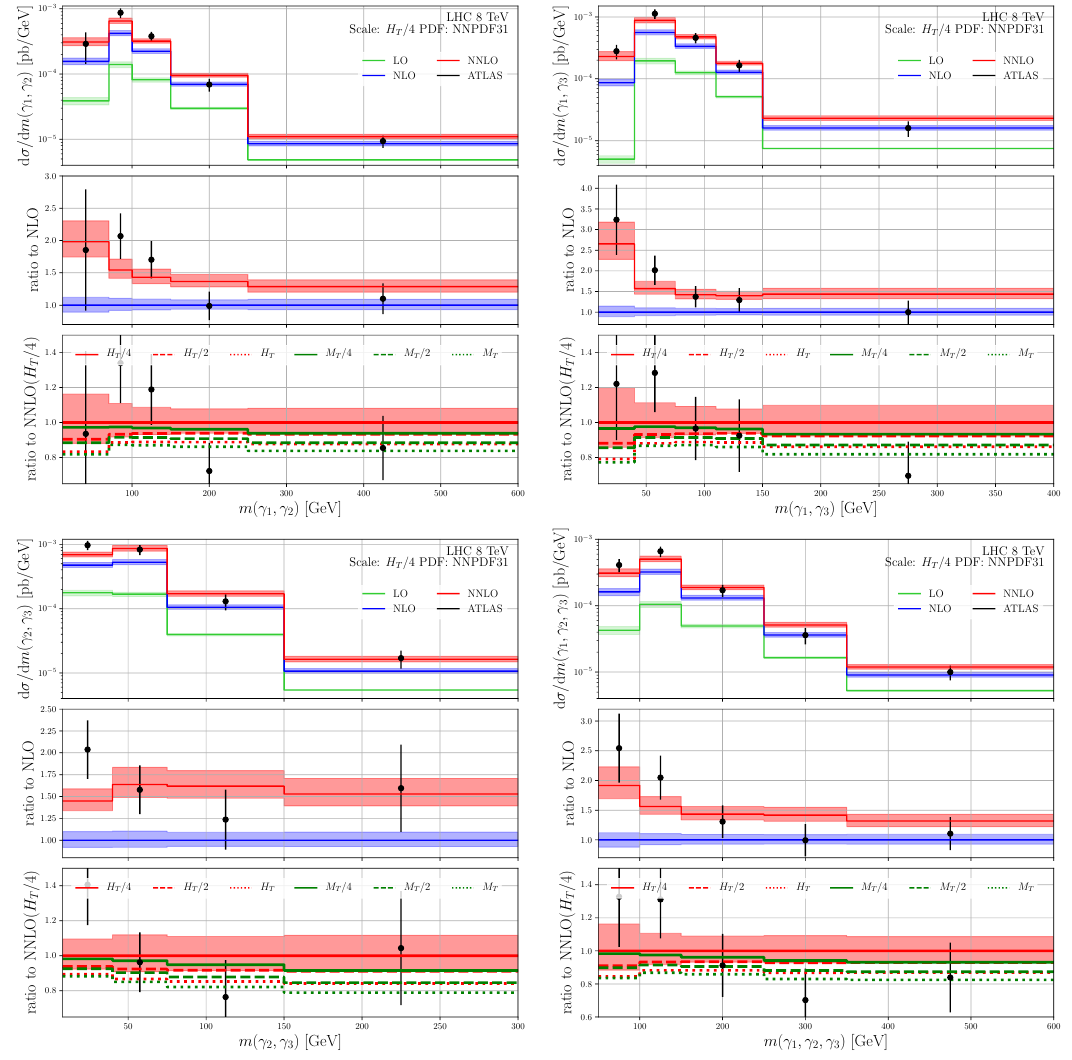
Figure 5 . As in (cid:12)gure 2 but for the m ( (cid:13) i ; (cid:13) j ) and m ( (cid:13)